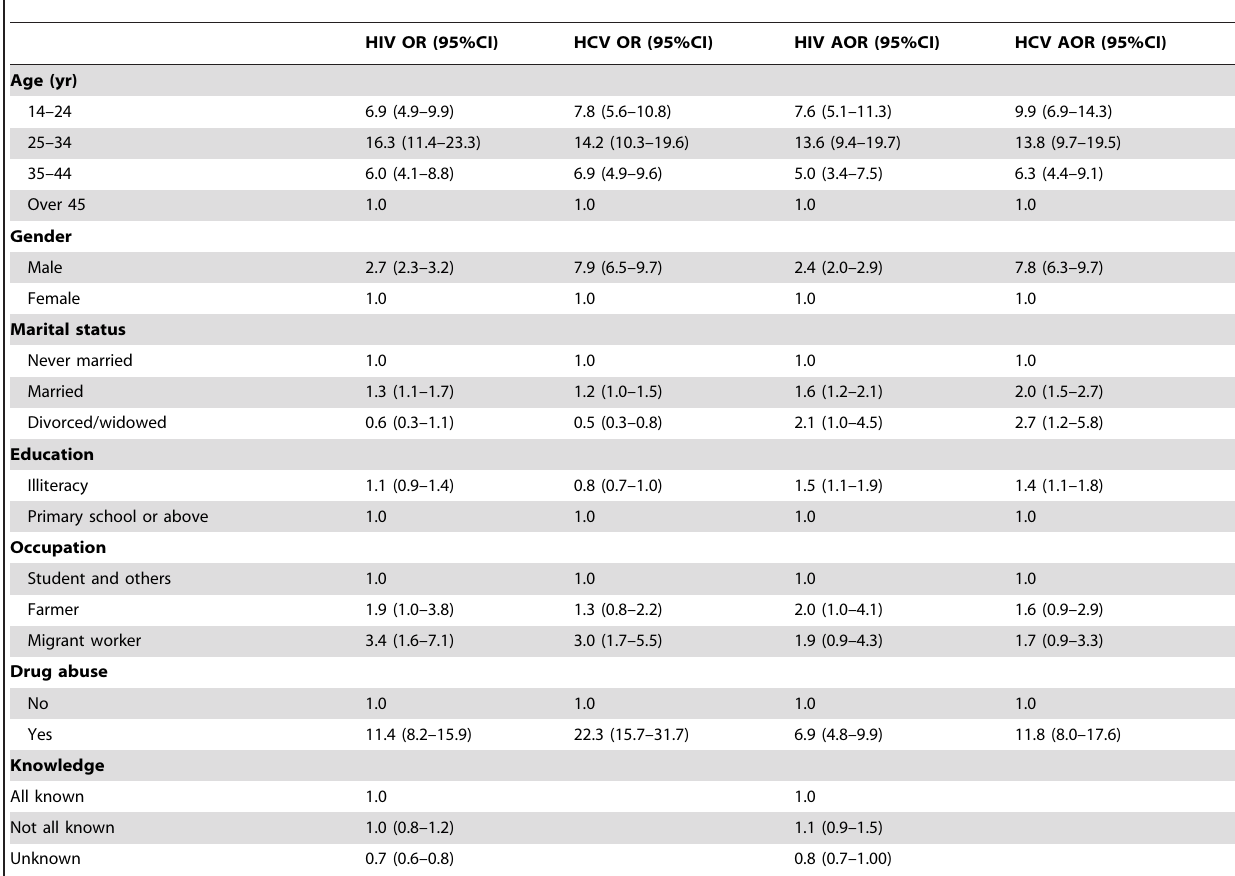
Table 3. Logistic regression analysis of HIV risk